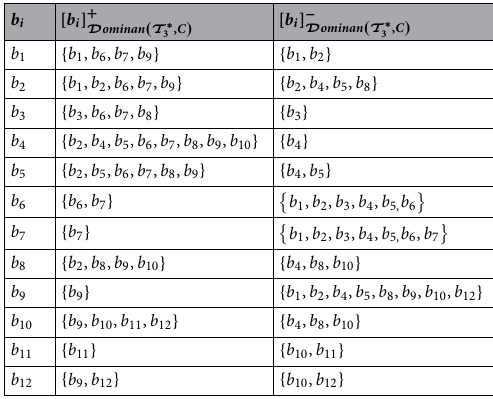
[ b i ] − D ominan ( T ∗ C ) 3 ,